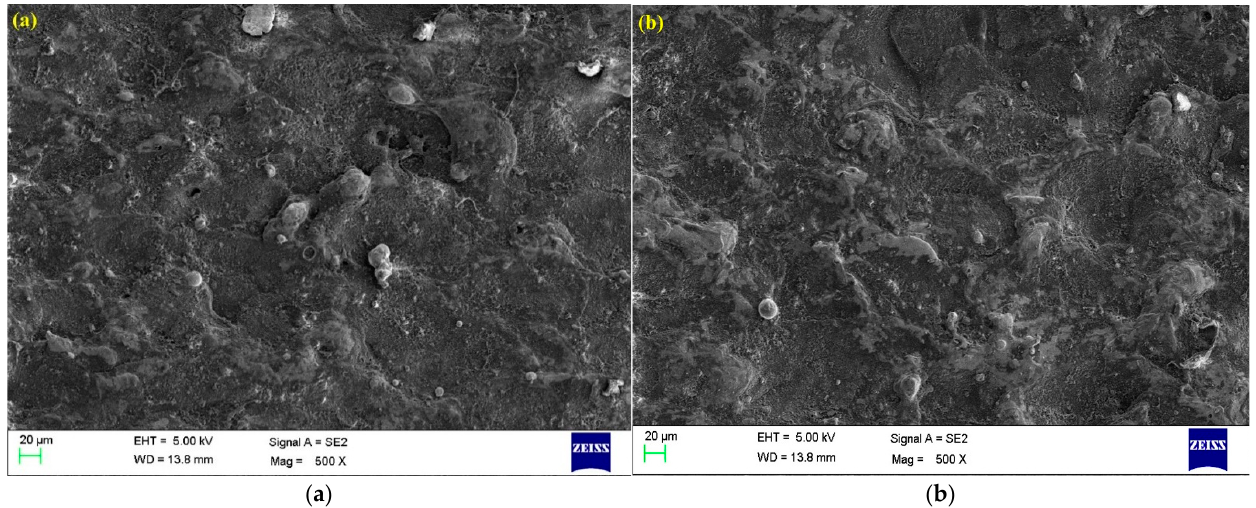
Figure 6. Surface morphology for ( a ) wet-WEDM, and ( b ) near-dry WEDM at optimized parameters.